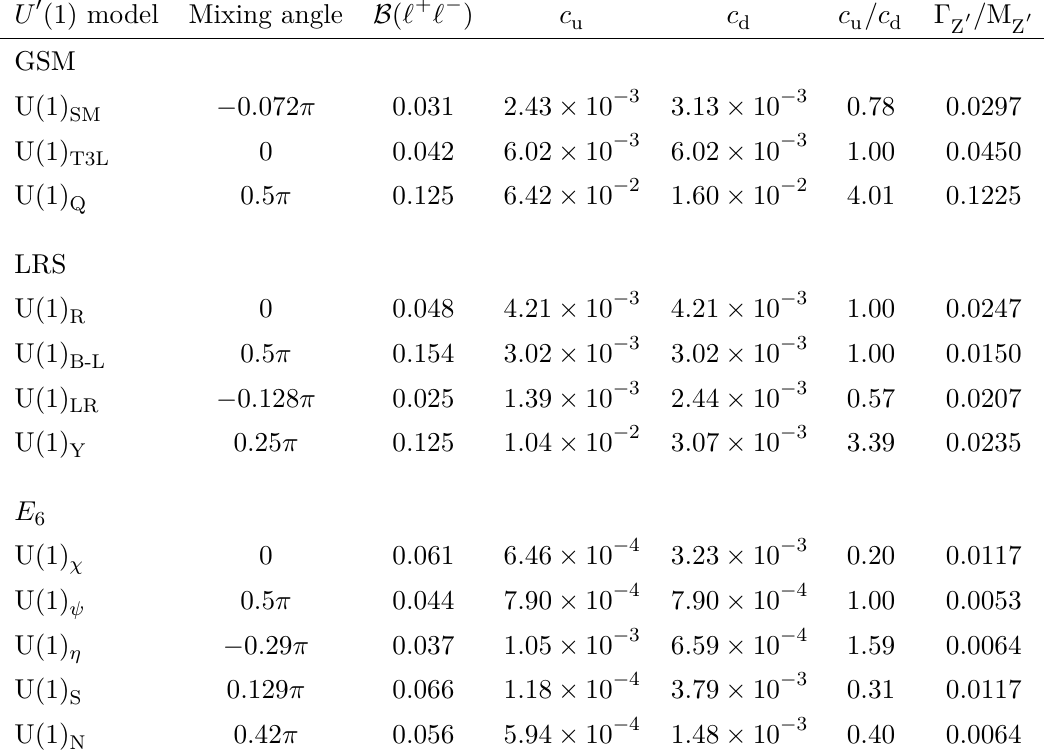
[1, 44] model classes, with 6 , c parameters u d